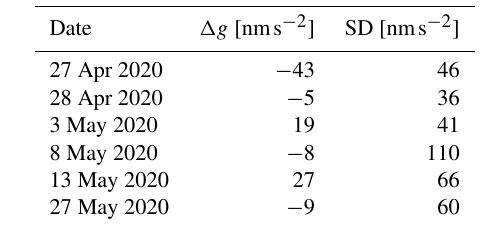
Table 2. AQG-B01: small-scale repeatability in Montpellier in 2020. Differences as residuals from the mean of the listed mea- surements, based on 24h averages. The standard deviation refers to